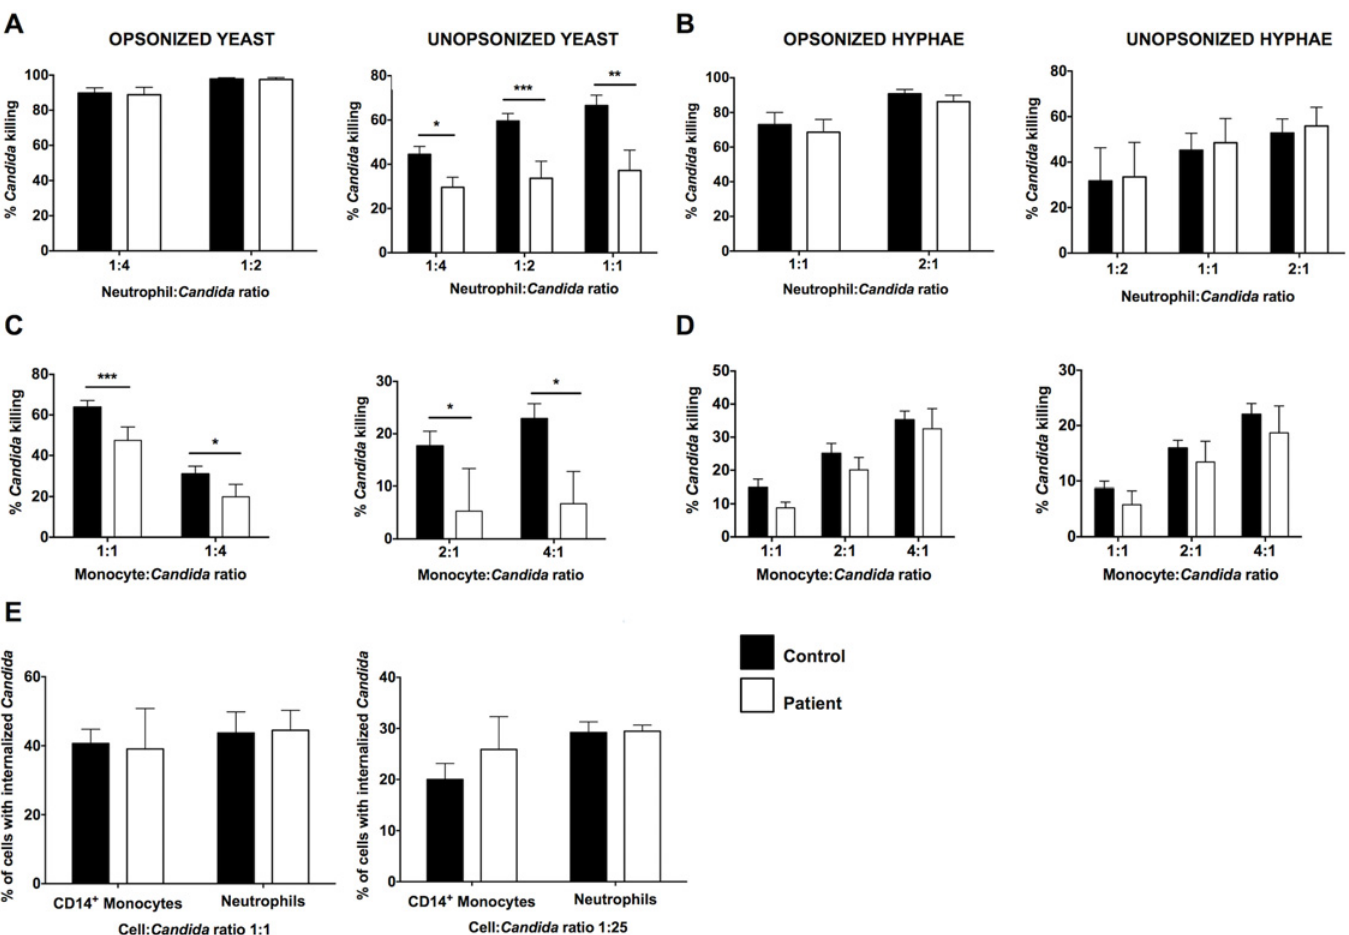
Fig 2. CARD9 mediates killing of Candida yeasts by human phagocytes but it is dispensable for the killing of invasive Candida hyphal forms that are found in infected tissue. Killing of opsonized and unopsonized Candida yeasts (A) and hyphal forms (B) by healthy donor and patient neutrophils (n = 5 – 7). Killing of opsonized and unopsonized Candida yeasts (C) and hyphal forms (D) by healthy donor and patient CD14 + monocytes (n = 5 – 8). (E) Internalization of opsonized (left panel) and unopsonized (right panel) Candida yeasts by healthy donor and patient neutrophils and CD14 + monocytes (n = 3 independent experiments). Data is analyzed by Mann Whitney U-test or unpaired t-test, where appropriate. * P < 0.05; ** P = 0.01; *** P < 0.001. All quantitative data represent mean ±